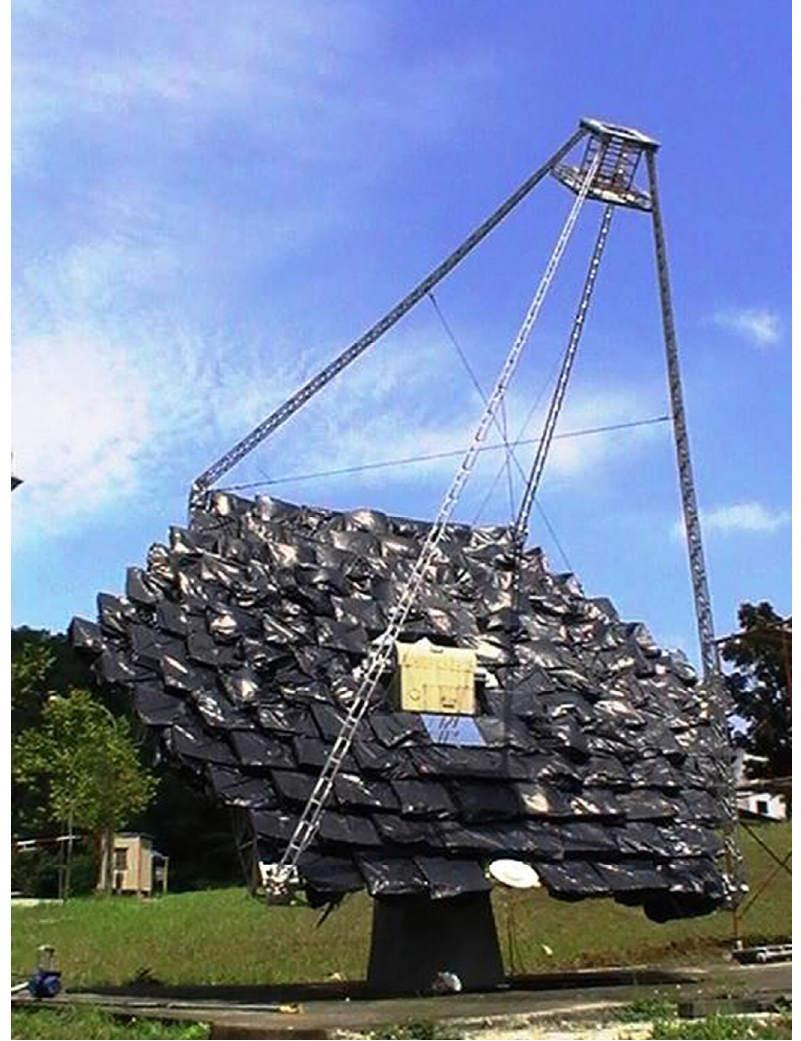
Figure 2. A prototype of on-axis solar concentrator that has been constructed at Universiti Tunku Abdul Rahman